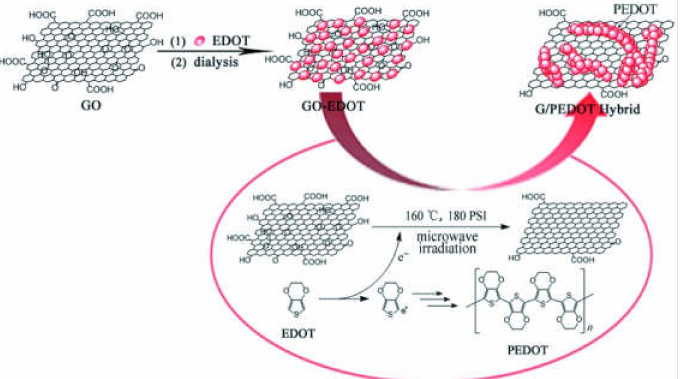
Figure 13. Schematic diagram of the preparation of the G/PEDOT hybrid through the microwave- assisted auxillary process for supercapacitor. Reproduced with permission from [203]. ChemPlusChem, 2013.